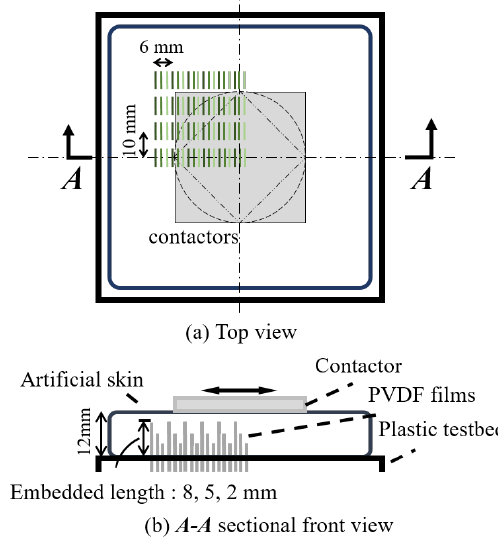
Figure 10. PVDF films’